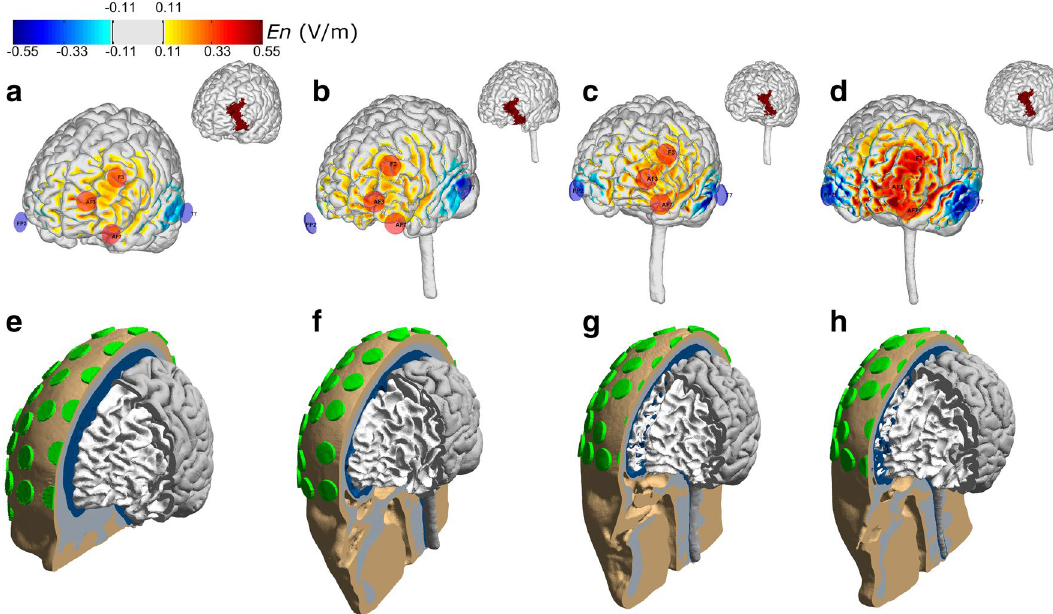
Figure 3. Distribution of the normal component of the E-field in the cortical surface of 4 of the head models used in this study. The distribution induced by the optimised montage on the cortical surface are shown in the top row for: the template head model (a) and the participants with the lowest, median and highest average E n in the left DLPFC (( b–d ), respectively). The head models for each participant are shown in the bottom row (e–h) , including the 61 electrodes present in the headcap used in this study. Figures were created using Comsol (Version v5.3a, https:// www. comsol. com/) and MATLAB (Version 2018a, https:// www. mathw orks.